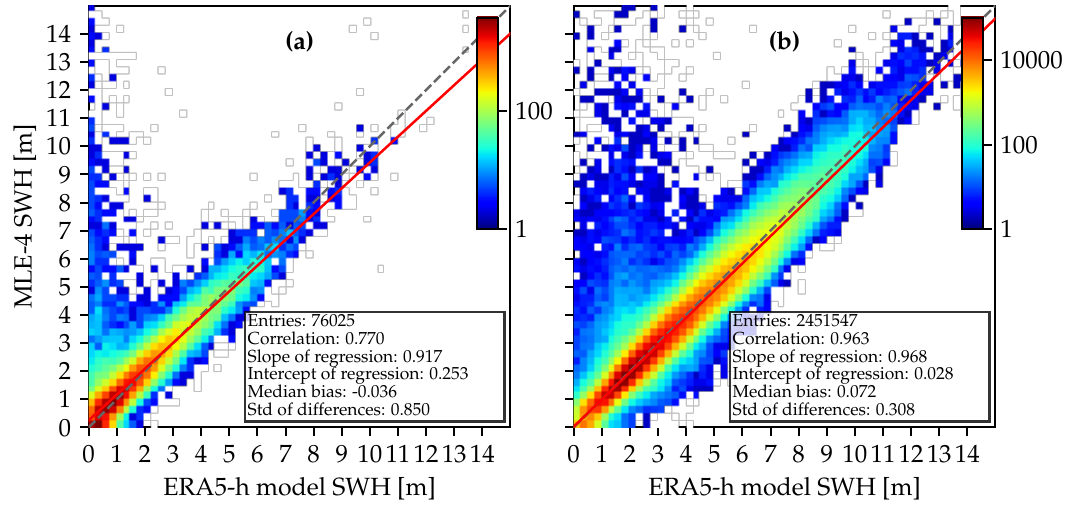
Figure 2. A 2D-histogram of MLE-4 against ERA5-h model considering ( a ) coast only and ( b ) open-ocean only. An SWH-interval bin size of 0.25 m is